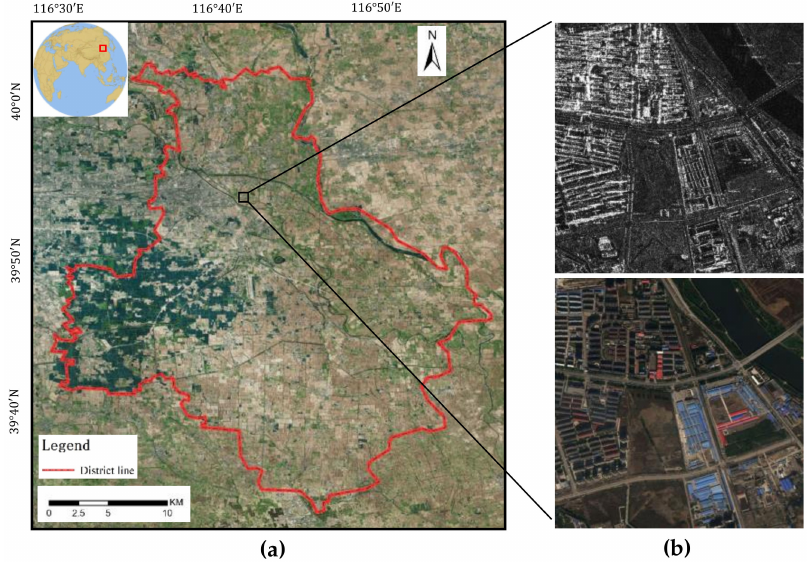
Figure 3. The time-series dataset of TerraSAR-X remote sensing images in the Tongzhou District of Beijing: ( a ) The study site; ( b ) The first scene of the dataset and corresponding optical